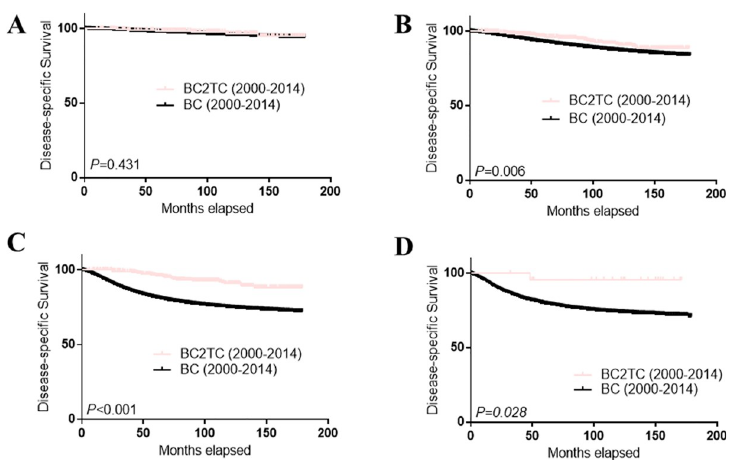
Fig 4. Comparison of DSS among different grades in the BC2TC and BC groups. BC vs BC2TC for grade I (A); BC vs BC2TC for grade II (B); BC vs BC2TC for grade III (C); BC vs BC2TC for grade IV (D).